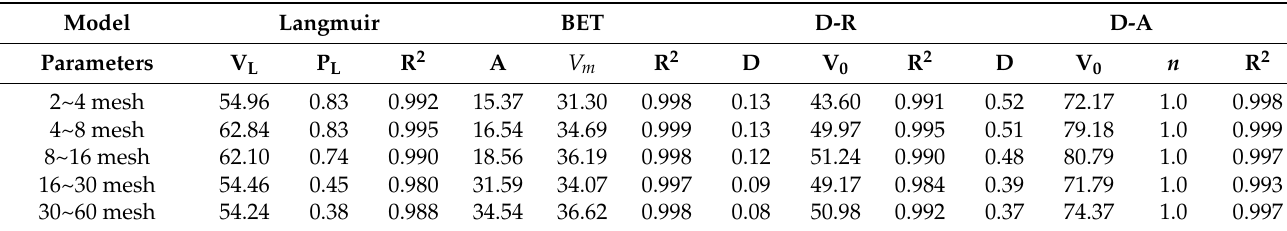
Figure 5. Fitting curves of four adsorption models: ( a ) 2~4 mesh; ( b ) 4~8 mesh; ( c ) 8~16 mesh; ( d ) 16~30 mesh; ( e ) 30~60 mesh. Table 4. Fitting data of four adsorption